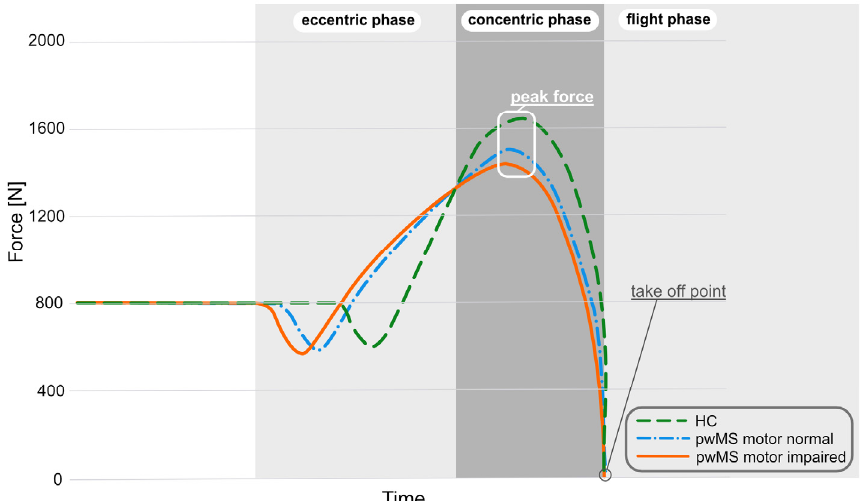
Figure 3. Examples of the countermovement jump force–time curves during the contraction time for pwMS motor normal , pwMS motor impaired , and HC. HC shows a rapid increase in force in the eccentric phase and a higher peak force than pwMS. Compared to HC and pwMS motor normal , the pwMS motor impaired show the longest contraction phase (eccentric + concentric phase). Abbreviations: HC = healthy controls; pwMS = people with multiple sclerosis.